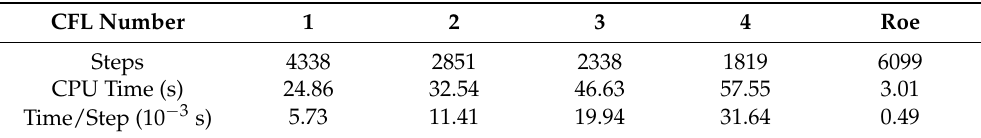
Table 7. Computational effort by a Godunov-type LTS solver compared to Roe’s scheme for different CFL